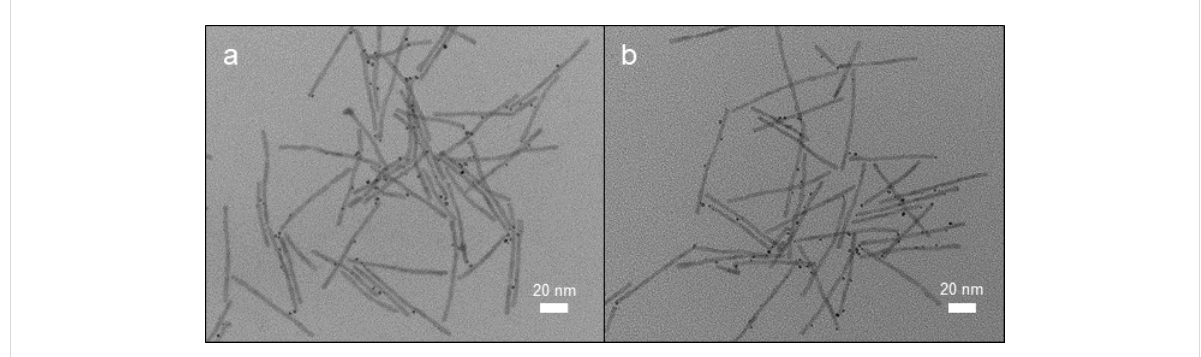
Figure 1: TEM images of Pt-decorated CdSe@CdS nanorods. a) Product of platinum deposition reaction conducted in toluene/triethylamine (tol-NR). b) Product of platinum deposition reaction conducted in [bmim][Tf 2 N] (IL-NR).